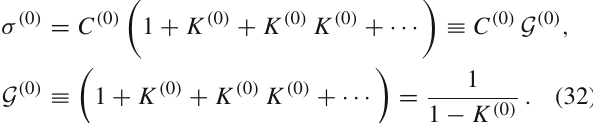
Fig. 5 Convolution of two generic 2PI amplitudes A and B . Notice that the indices α , β and γ maybe spinor as well as Lorentz indices, depending on the particles going in and coming out of the kernels. The whole kernel, which we can denote by C , is given by the convolution (cid:16) αα (cid:8) d n l ( k , l ) B γγ (cid:8) ( l , q C αα (cid:8) ββ (cid:8) ( k , q ) = ( 2 π) n A γγ (cid:8) ββ (cid:8)